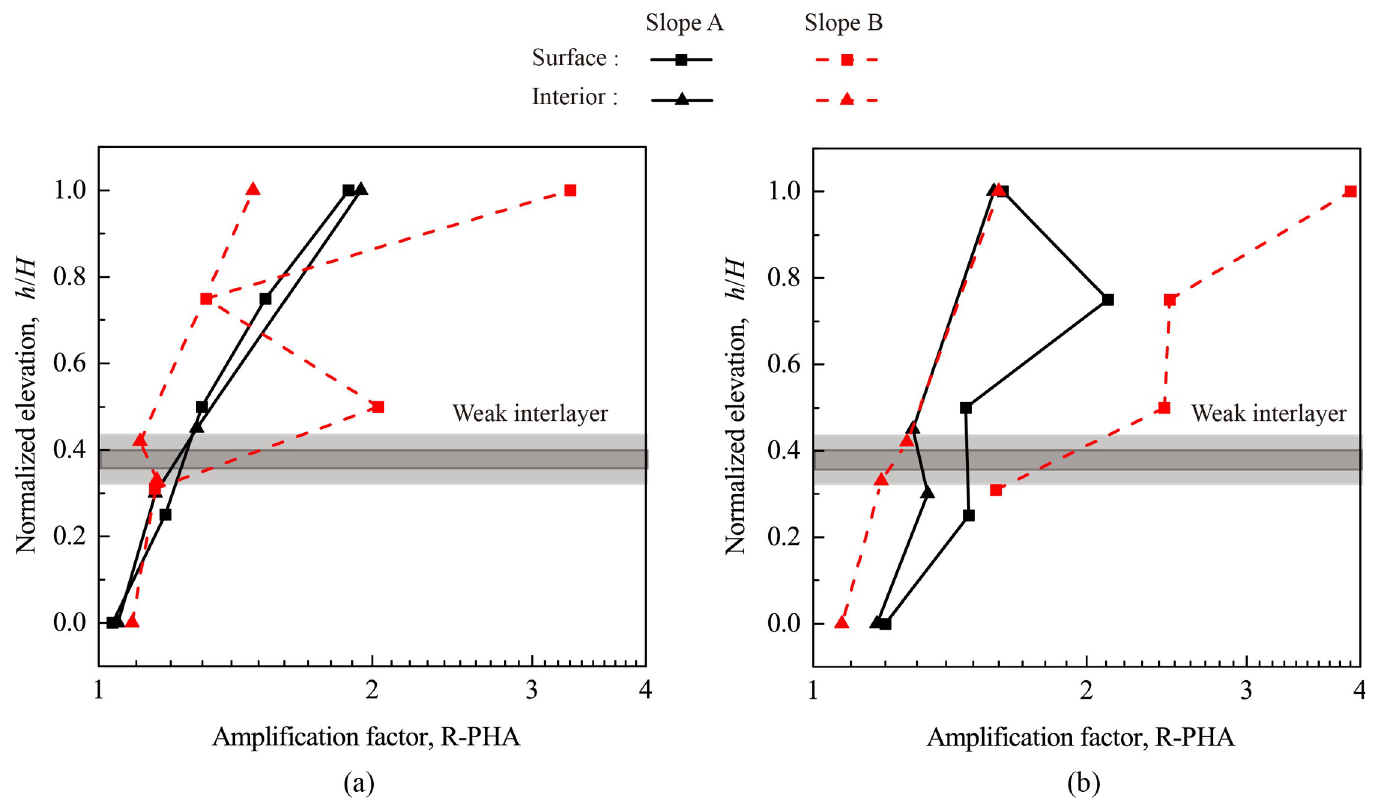
Fig 6. Topographic amplification of peak horizontal acceleration (R-PHA) under 0.1 g and 0.8 g levels of horizontal shaking: (a) 0.1 g; (b) 0.8 g.